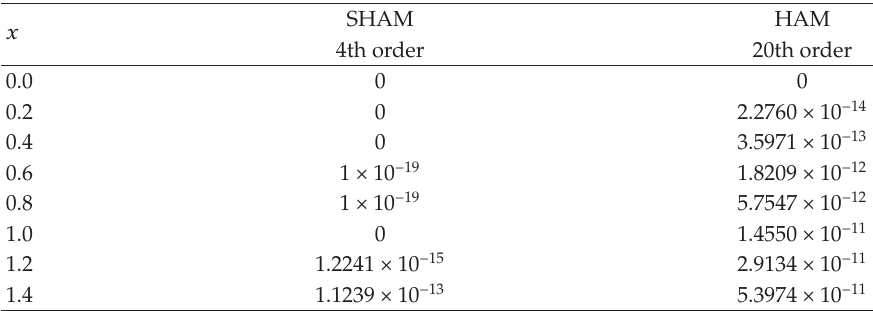
Table 5: Absolute errors for Example